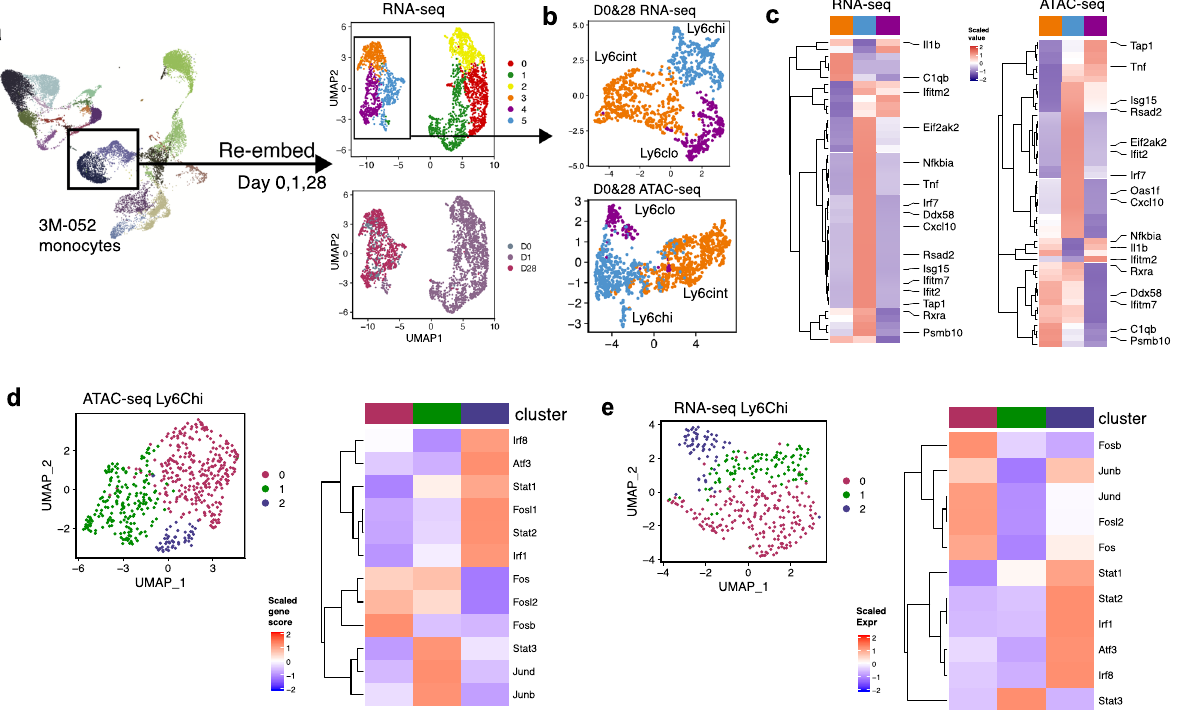
Fig. 6 Differentially expressed and accessible genes in 3M-052-Alum/OVA are driven by different sub-clusters of monocytes on Day 28. a Re- embedding of monocytes present before (day 0) and 1 and 28 days after immunization with 3M-052-Alum/OVA in scRNA-seq. b Sub-clustering and re-embedding of monocytes at baseline and 28 days after 3M-052-Alum/OVA immunization in scRNA-seq (top) and scATAC-seq (bottom). c Gene expression and accessibility score of antiviral BTM module highlighted in Fig. 5b, across day 0 and day 28 monocyte subclusters. d Re-clustering of Ly6Chi monocyte subcluster identi fi ed in ( c ) (left); heatmap of Irf and AP-1 gene accessibility within Ly6Chi monocyte subclusters (right), performed on scATAC- seq data. e Re-clustering of Ly6Chi monocyte subcluster identi fi ed in ( c ) (left); heatmap of Irf and AP-1 gene accessibility within Ly6Chi monocyte subclusters (right), performed on scRNA-seq